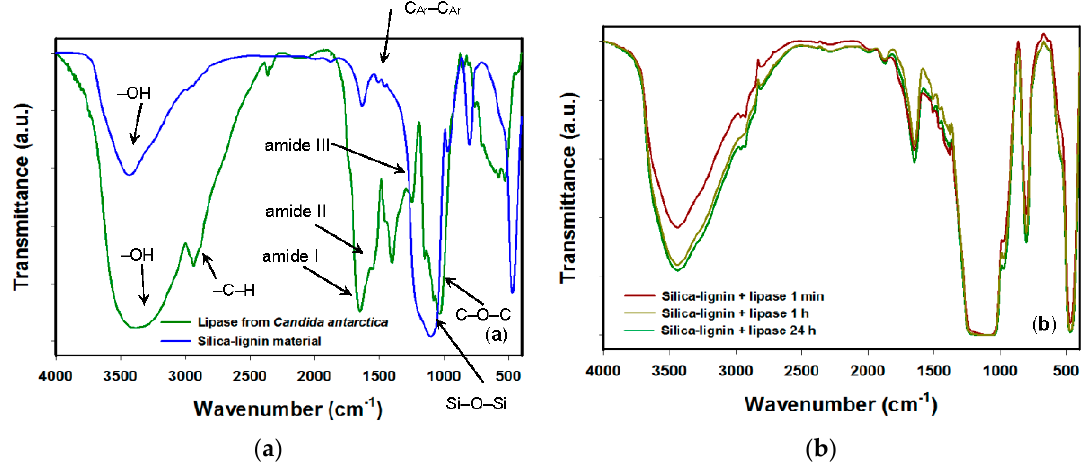
Figure 1. FTIR spectra of silica ‐ lignin matrix and lipase B from Candida antarctica ( a ) and products following immobilization ( b ).